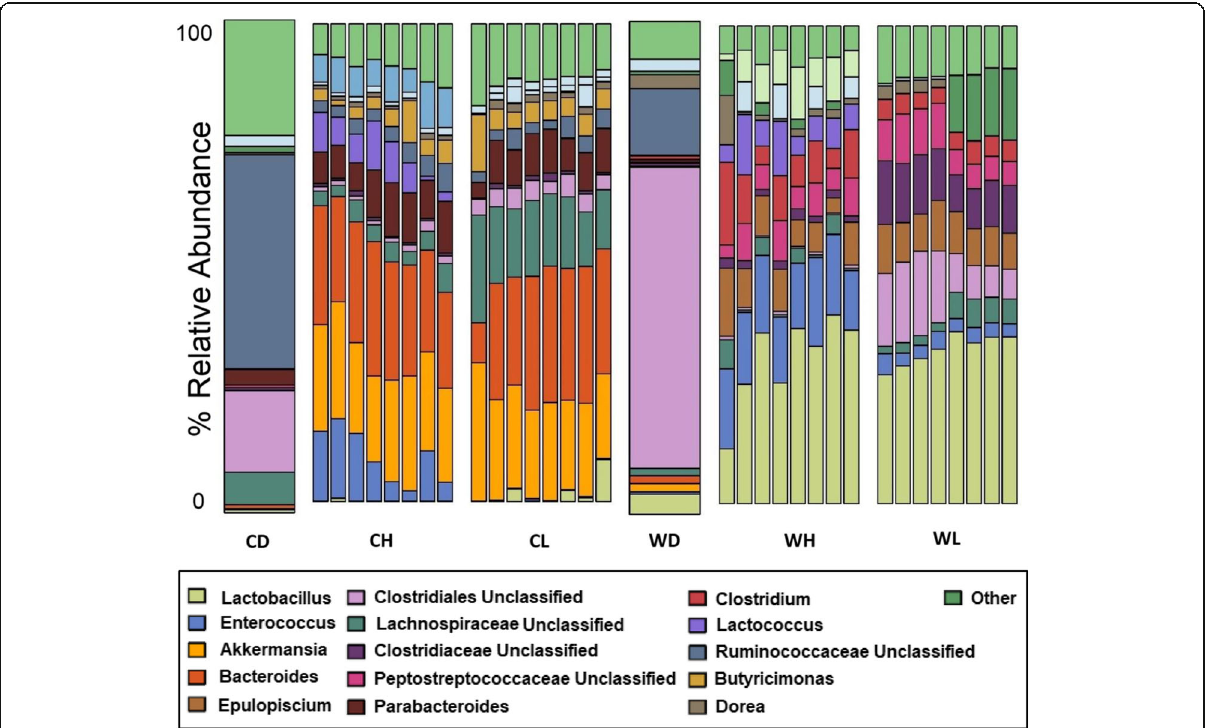
Fig. 4 Relative abundance of the top 15 genera in fecal samples immediately before sacrifice. CD and WD bars represent the donor FMTs. All other bars represent 8 mice per group: Captive High (CH), Captive Low (CL), Wild High (WH) and Wild Low (WL). Each color represents a genus in proportion to its relative abundance in each group. We did not find differences between earlier timepoints and the final timepoint with regards to the genera presented here, thus we are showing genera in samples immediately before sacrifice to avoid redundancy.